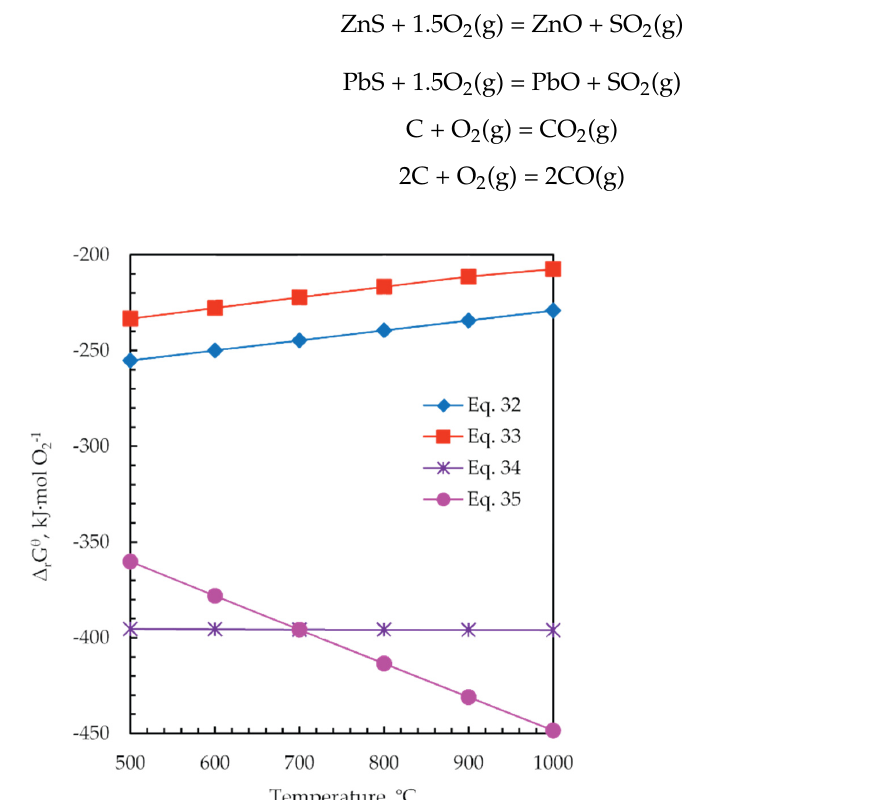
Figure 13. The predominance area diagram of Zn-S-O, Pb-S-O and Fe-S-O system at 550 °C.